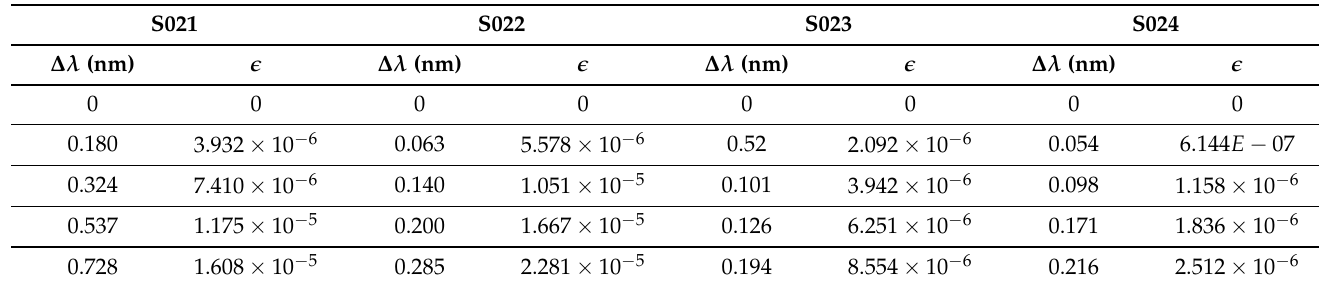
Table 1. Sensors and bar deformations.